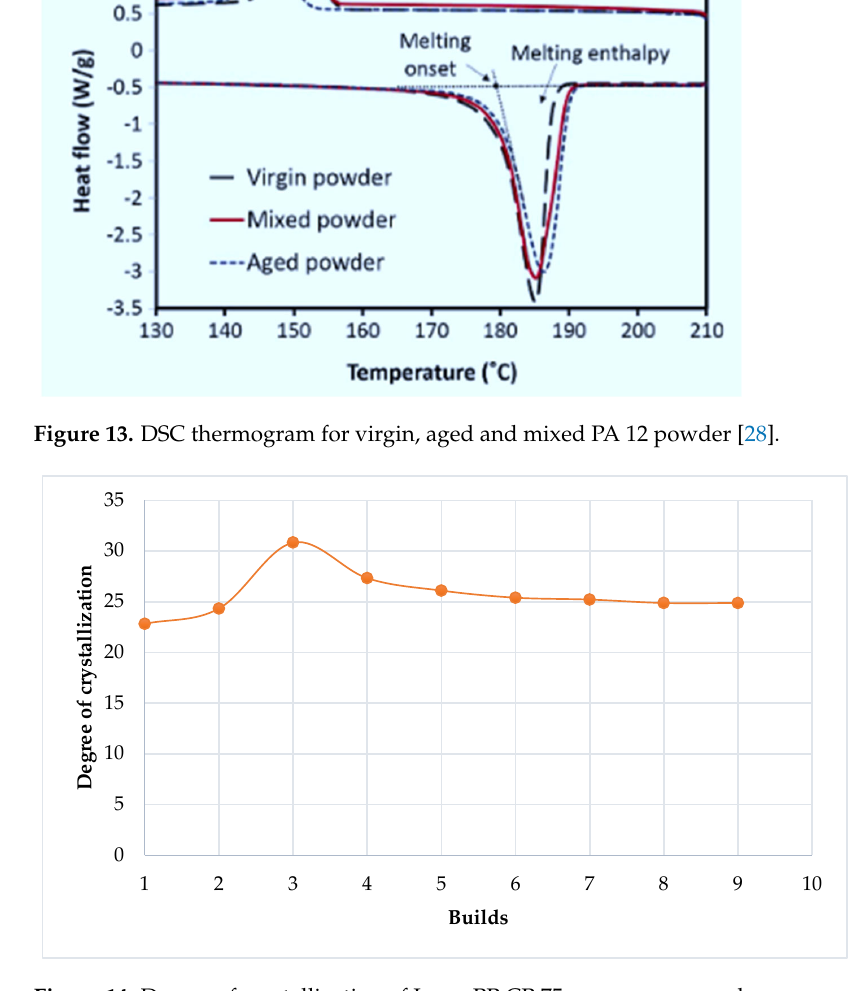
Figure 14. Degree of crystallization of Laser PP CP 75 versus re ‐ use cycles.